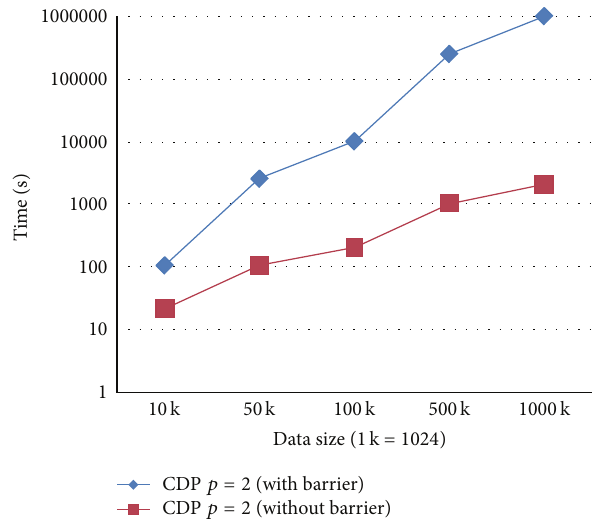
Figure 8: Impact of the barrier cudaDeviceSynchronize() on execu- tion